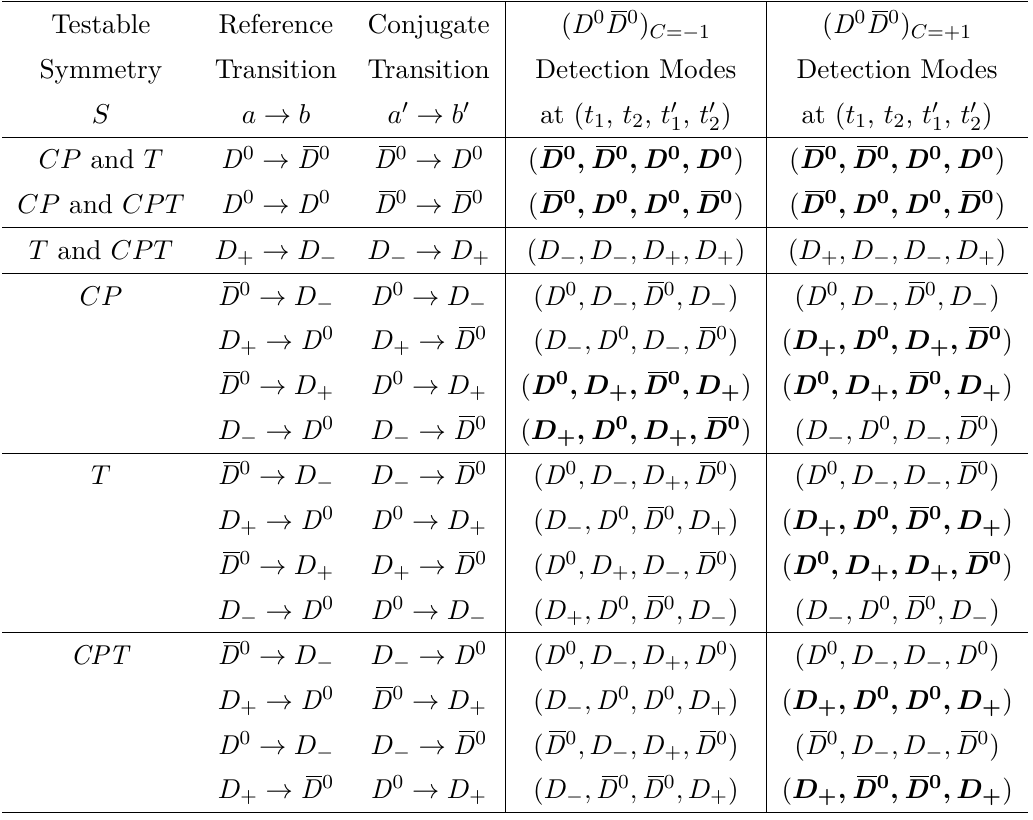
Table 4. The fifteen possible pairings of reference and symmetry conjugated transitions used to study CP , T and CPT for pairs of neutral D mesons, as demonstrated by Bevan [96, 97]. In four of these pairings, both a and a 0 can be established without the use of C -correlated charm (e.g. via D ∗ + → D 0 π + flavor tags) and thus the symmetry can also be tested elsewhere. Listed next to these pairings are the states that must be measured at ( t 1 , t 2 , t 0 , t 0 ) for C = − 1 and C = +1 correlated 1 2 D 0 D 0 systems, to establish the conjugated-transitions pair (see figure 4). Sets of states that do not require D − to be reconstructed are highlighted in bold ; only C = +1 correlated D 0 D 0 allow